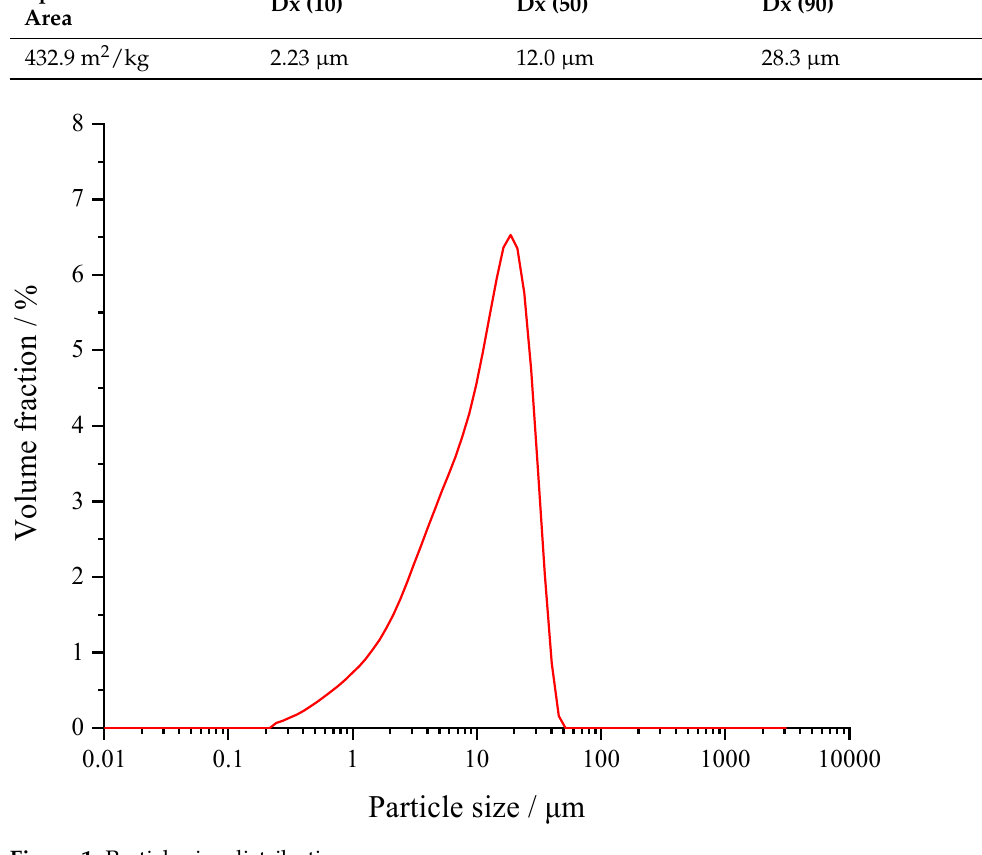
Figure 1. Particle size distribution curve.